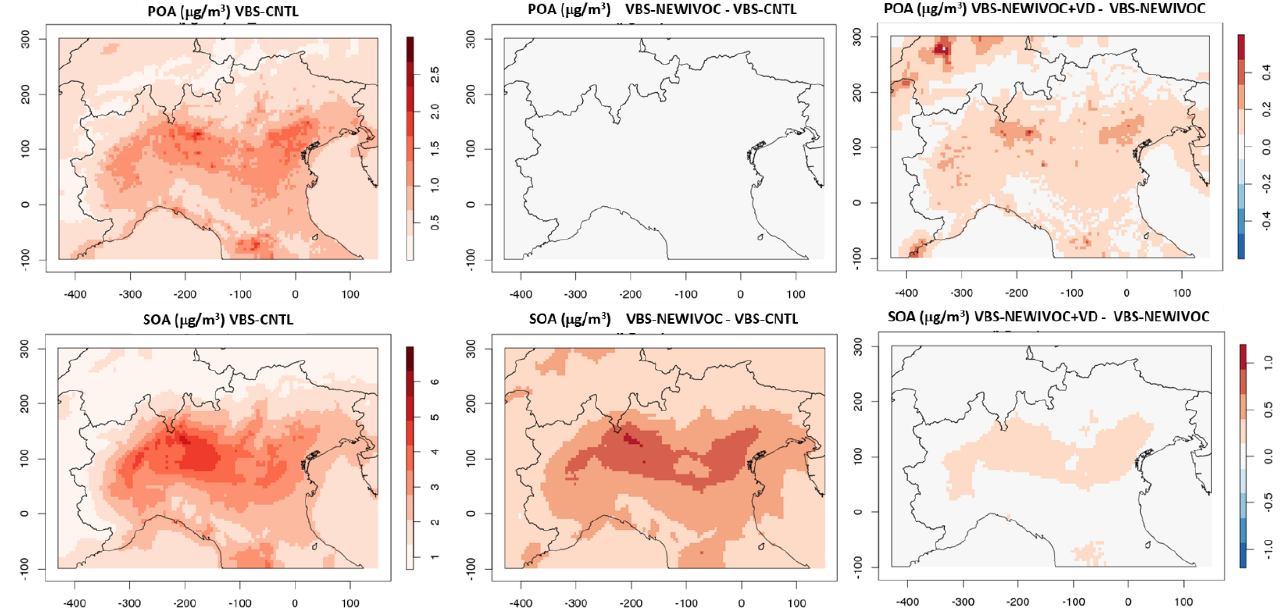
Figure 15. Modeled POA and SOA average concentrations for the quarter period of May–July 2013: VBS-CNTL (left panels), estimated contribution of IVOC emission revision (middle panels, difference between VBS-NEWIVOC and VBS-CNTL simulation) and estimated contribution of OM volatility revision (right panels, difference between VBS-NEWIVOC+VD and VBS-NEWIVOC simulation).